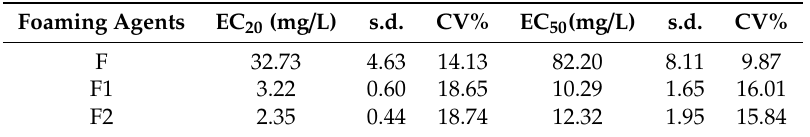
Table 4. Ecotoxicity of the three commercial foaming agents (F, F1 and F2) as EC 20 and EC 50 , expressed as Bioluminescence inhibition (%) of the bacterium V. fischeri . s.d. = standard deviation; CV% = coe ffi cient of variation.